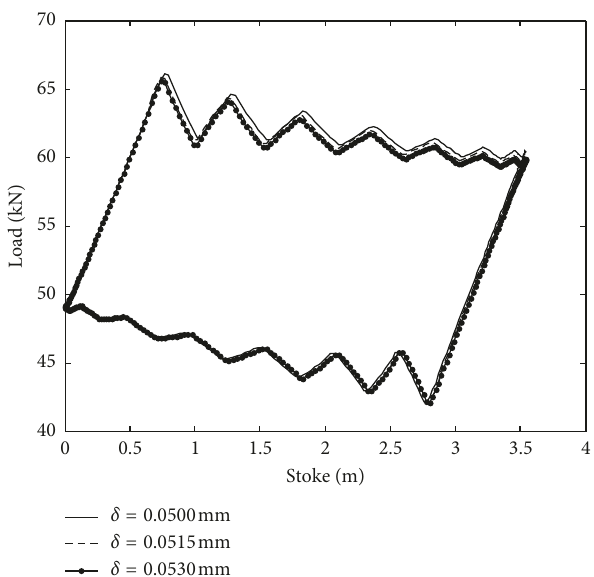
Figure 11: Polished rod dynamometer cards of well